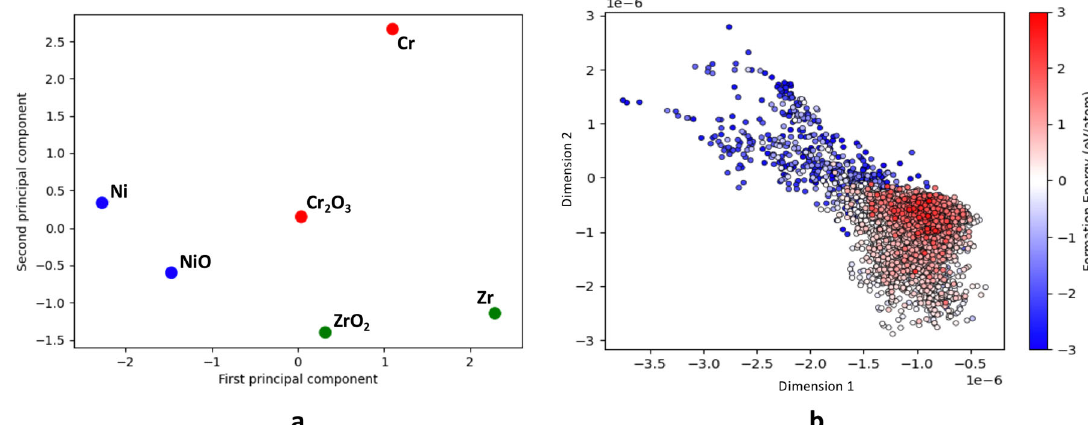
Fig. 4 Dimensionally-reduced compound vectors. a 200-dimensional SkipAtom vectors for Cr, Ni, and Zr, and their mean-pooled oxides, dimensionally reduced using PCA. b Plot of a sampling of the dimensionally-reduced compound vectors for the OQMD Dataset Formation Energy task, mapped to their associated physical values. The points are sum-pooled one-hot vectors reduced using t-SNE with a Hamming distance metric. The sum-pooled one-hot representation was the best performing for the task. Table 3. Benchmark regression task results after two-repeated fi ve- or ten-fold cross-validation; mean best MAE on the test set after 100 epochs of training in each fold.